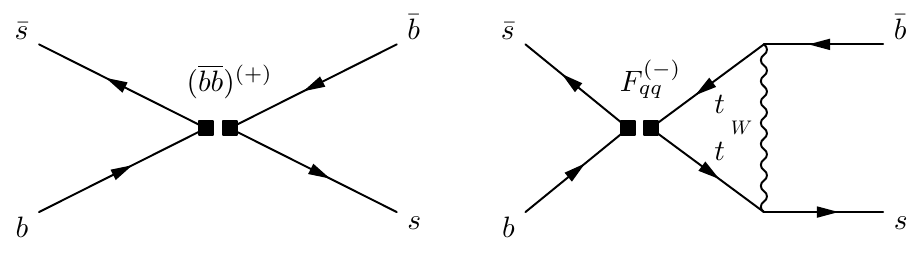
Figure 1 . Illustration of SMEFT operator contributions to B s mixing observables. Left: tree-level topology, with insertion of ( bb ) (+) . Right: one-loop topology, involving a charged current with the insertion of F ( − ) ; see eq. (3.15). The operator insertion is illustrated by two filled squares, each qq indicating a quark